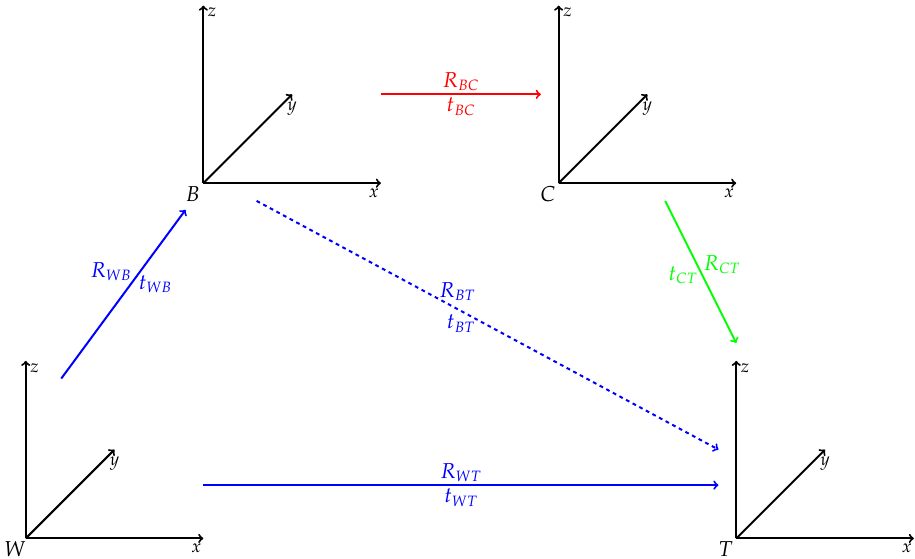
Figure 5. Visualization of the different frames present during extrinsic camera calibration and the transformations between them. The blue-colored transformations can be either directly measured (solid) or calculated (dashed) using our motion capture system. The green-colored transformation can be determined using standard computer vision algorithms, as ArUco tags are commonly used for pose estimation [42]. Finally, the red-colored transformation is the one be determined using calibration. W refers to the world frame defined by the motion capture system, B is the tracking body frame of the camera, C is the camera frame, and T represents the frame of the ArUco